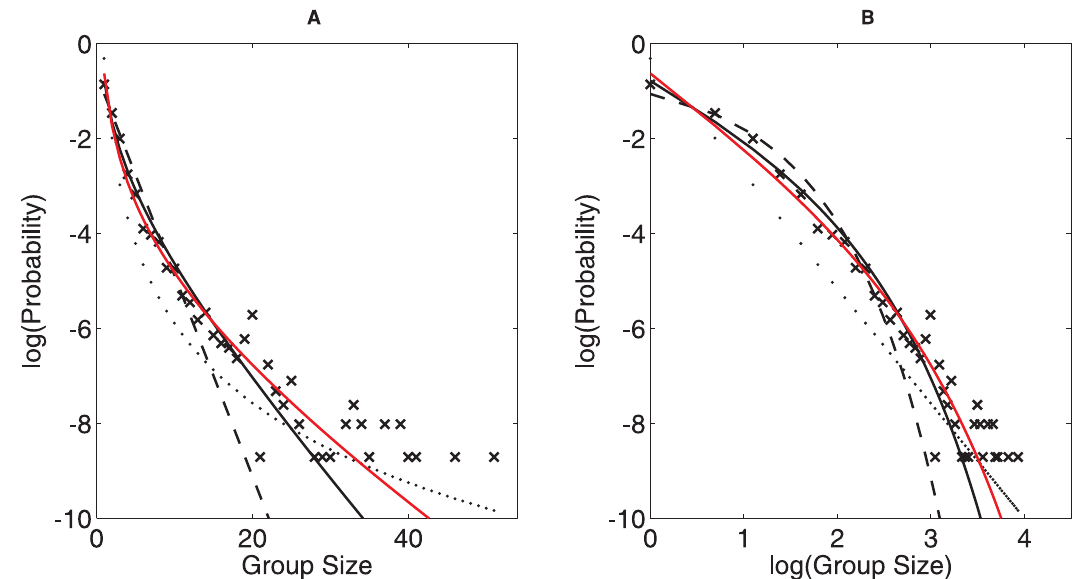
Figure 1. Distribution of group sizes for all observations. Comparison of the empirical data (x) with N mean =2.9 and N P =7.3, a power law (dotted line) with a =2.42, geometric distribution (dashed line) with p=0.35, logarithmic distribution (solid line) with N P =6.4, truncated power law by MLE (almost congruent with the line for logarithmic distribution and thus not displayed) with a=0.99, c=0.84 and truncated power law by minimizing x 2 value (red line) with a=1.45, c=0.91 on a semi-log (A) and a log-log plot (B). Number of observations: n =6070.